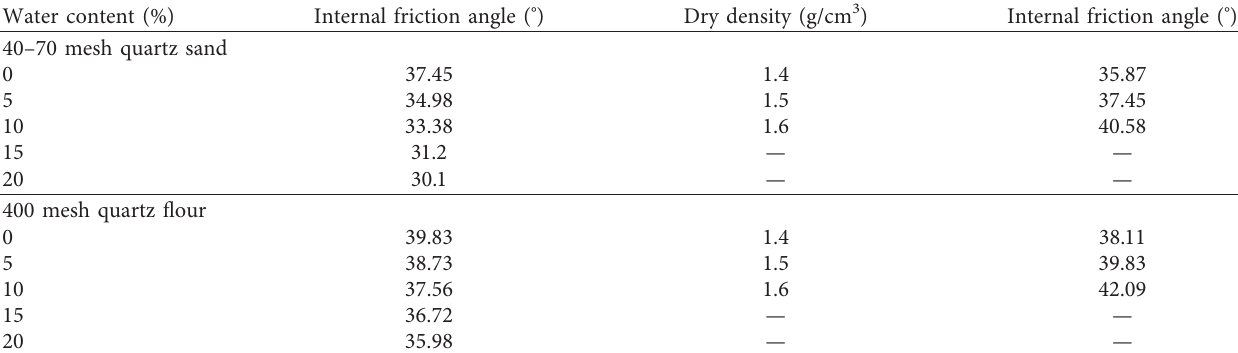
Table 5: Quartz sand and quartz flour direct shear test